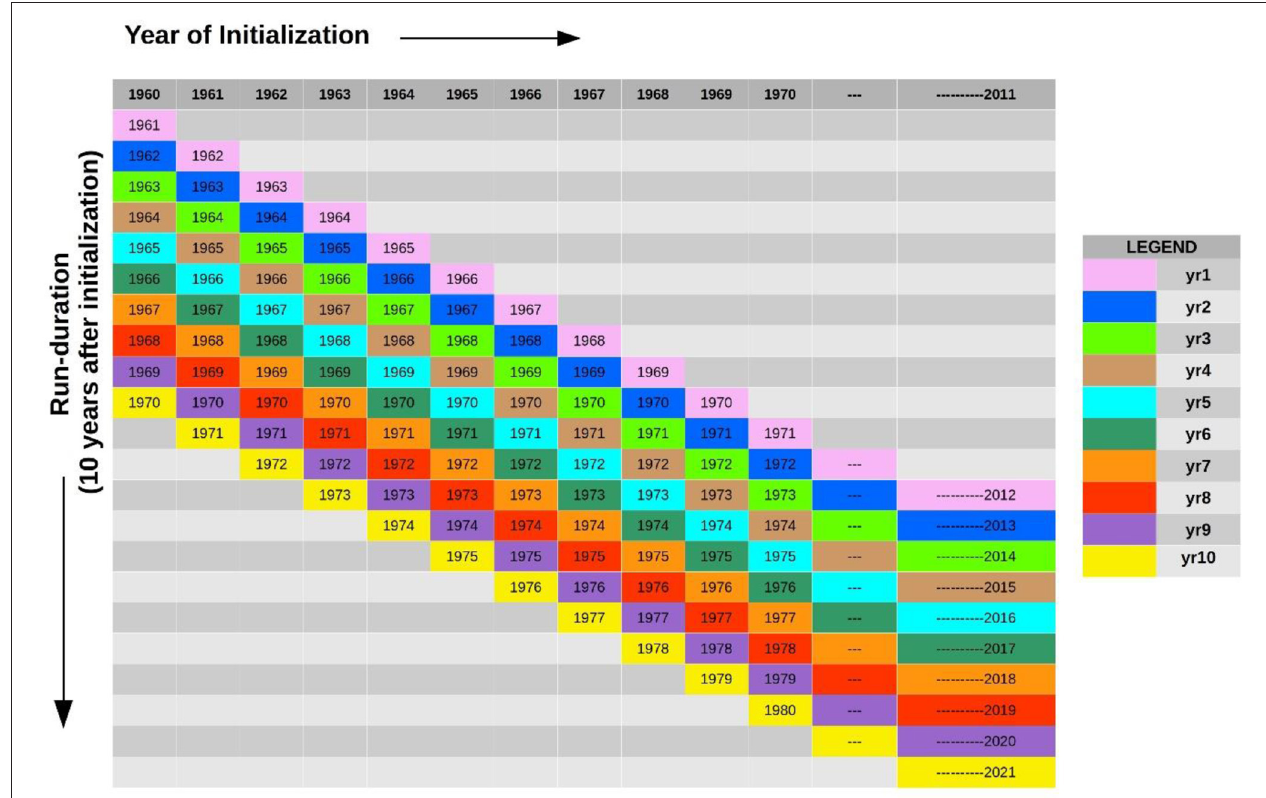
FIGURE 1 | The output data from all the models are divided into 10 groups depending on the year after initialization. Yr1, yr2, yr3… indicates 1, 2, 3 … year(s) after initialization, which is represented by individual